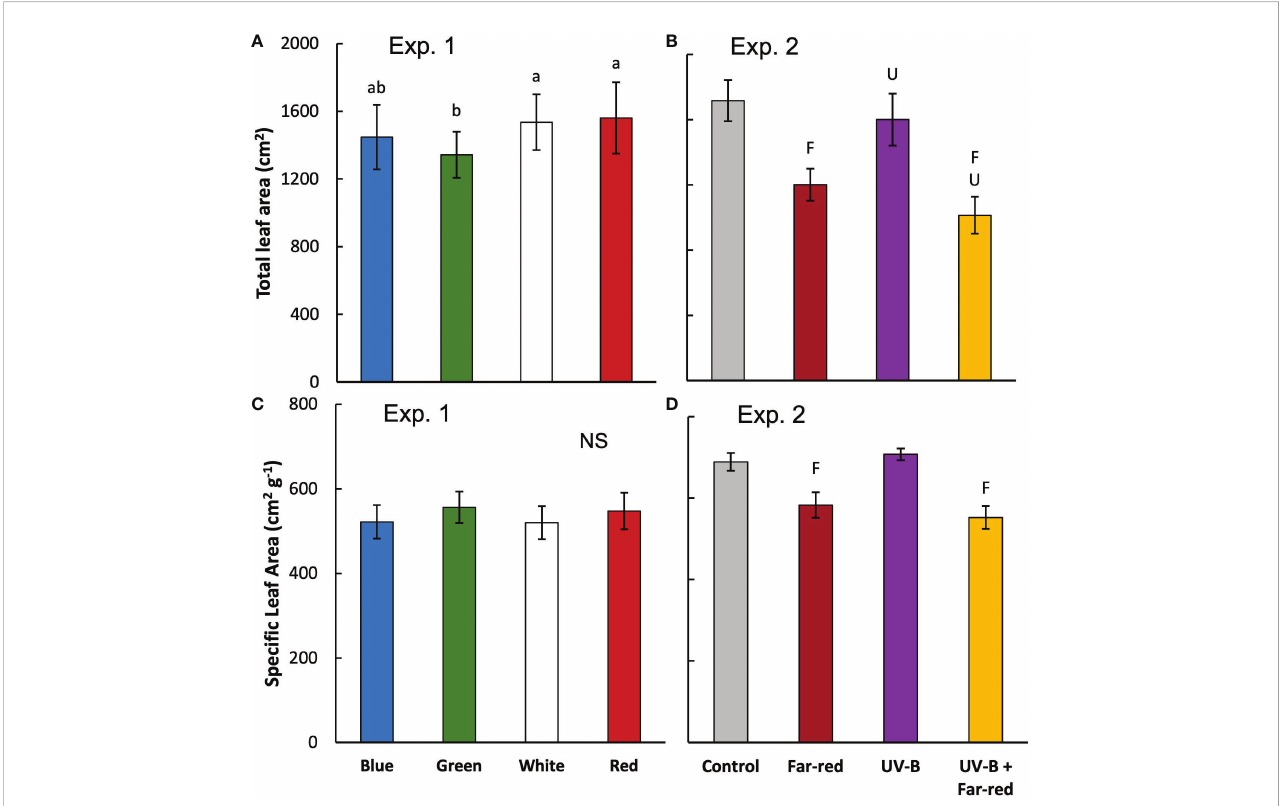
FIGURE 2 Total leaf area (from both main stem and side shoots) per plant (A, B) and speci fi c leaf area (calculated as leaf area divided by leaf dry weight; average value from all leaves) (C, D) measured at fi nal harvest in treatments of supplemental radiation within (A, C; Exp 1) and outside (B, D; Exp 2) the range of PAR (values are mean ± s.e.; n = 4, with 15 plants in each statistical replicate). Details on the treatment abbreviations can be found in Figure 1. In panel A and C, letters indicate signi fi cant differences ( p < 0.05) and “ NS ” indicates non-signi fi cant difference. In panel (B and D, “ F ” and “ U ” respectively indicate a signi fi cant effect of far-red and UV-B ( p <